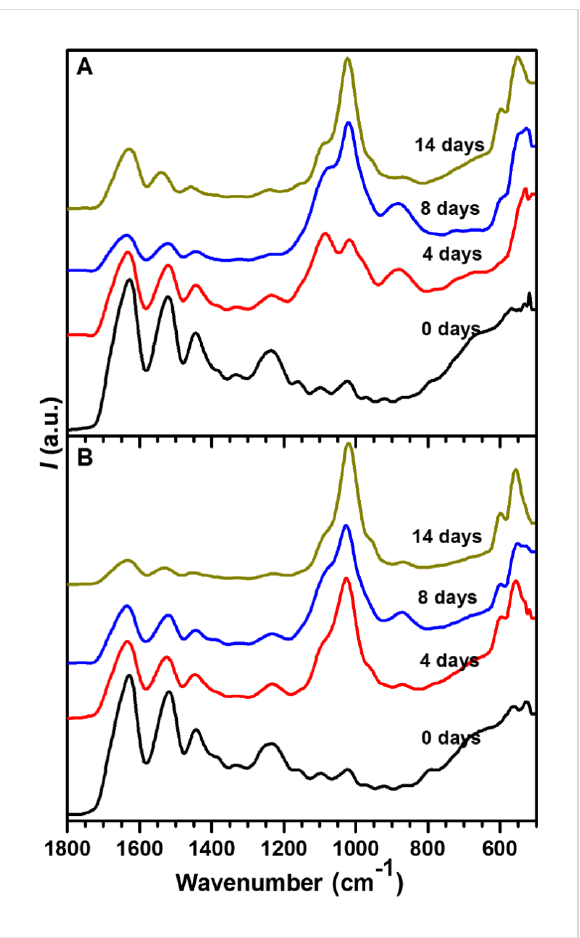
Figure 4: ATR-IR spectra of the mineralized hydrogels: (A) IK24 hydrogel, and (B) H3AH3 hydrogel after different incubation times.